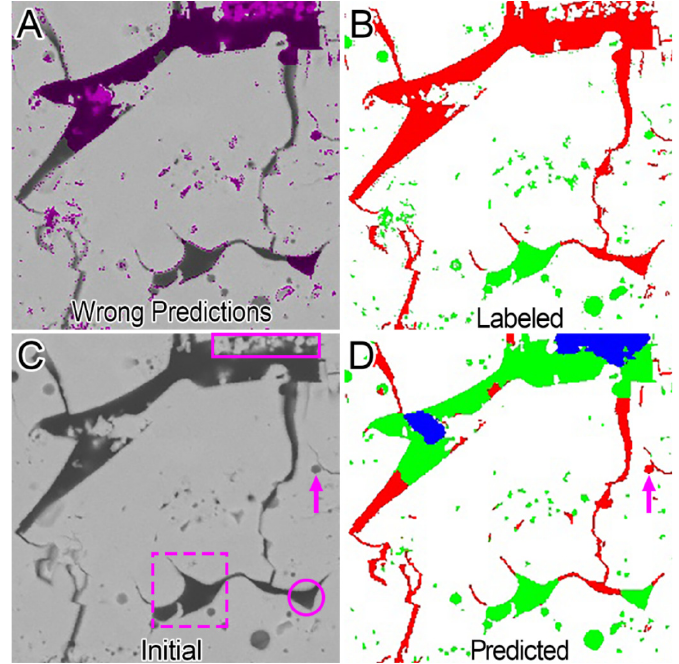
Figure 17. The lowest-accuracy (87.0%) test image ( A ), in which wrong predictions are marked by purple, together with the labeled image ( B ), the initial grayscale image ( C ) (violet solid rectangle indicates a region where wrong predictions occurred due to wrong label, violet dashed square indicates a region where an equiaxed pore and cracks are connected, circle indicates a region where both the wrong prediction and the label seem to be reasonable), and the predicted image ( D ) (arrow indicates an equiaxed pore that was wrongly predicted as a crack).